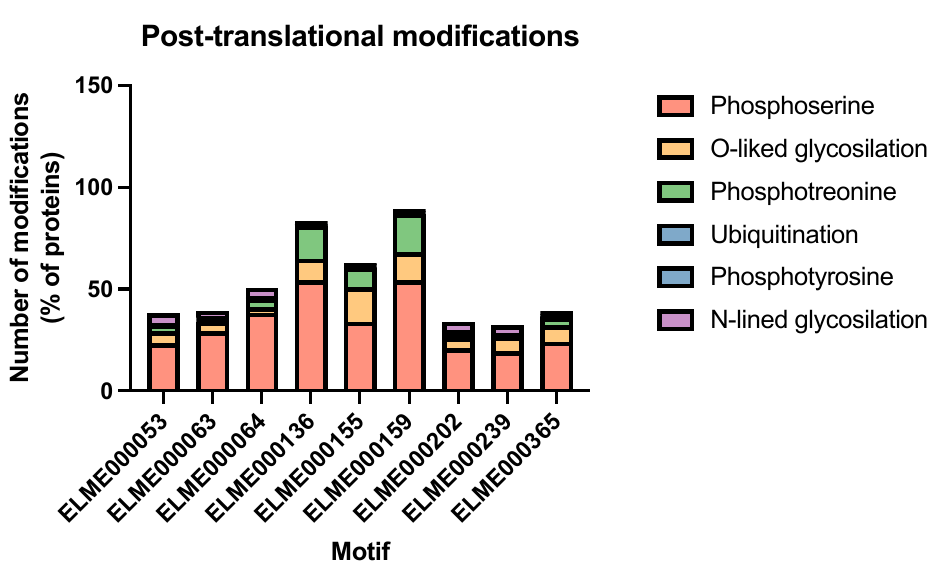
Figure 6. Post-translational modifications in enriched motifs. The sequences were inspected using MusiteDeep [36] and modifications were reported as the percentage of proteins containing a given modification for each